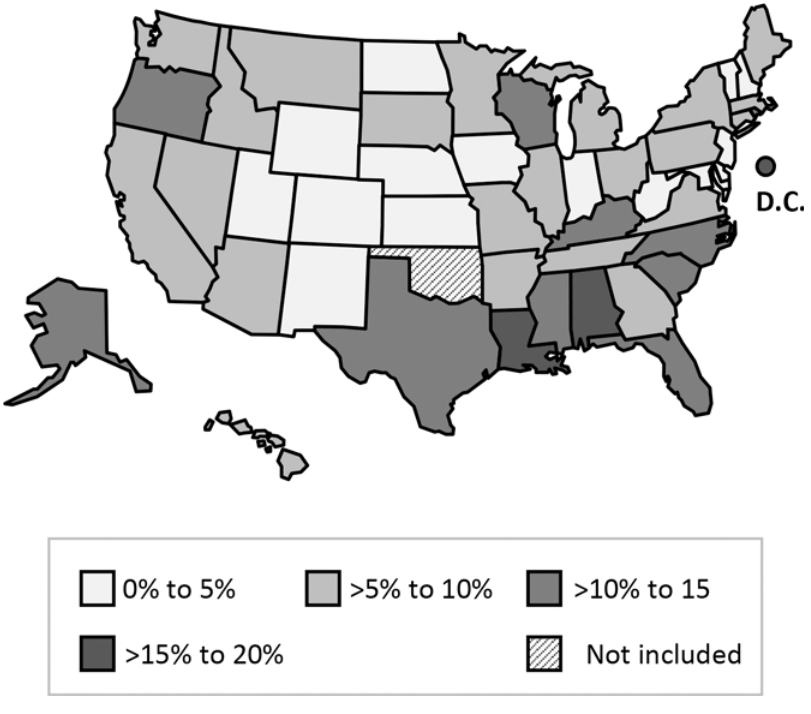
Fig 2. Map of states by proportion of cases attributed to limited recent transmission — January 2011 – September 2014.